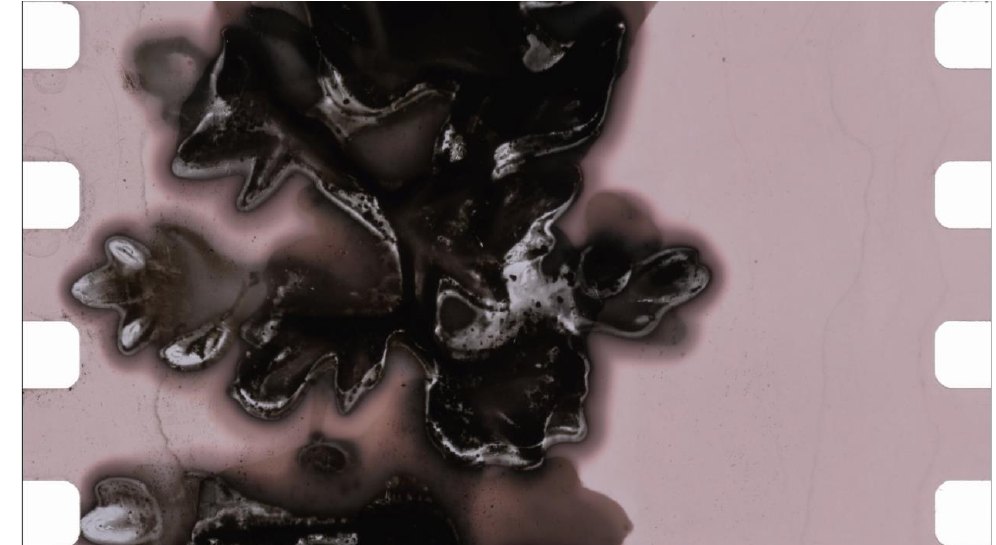
tions (stems, leaves, or petals) are placed against surfaces after being appropriately soaked, imagery of plants’ bodies besides their chemical reactions with the substrate can form (Figure 3). 20